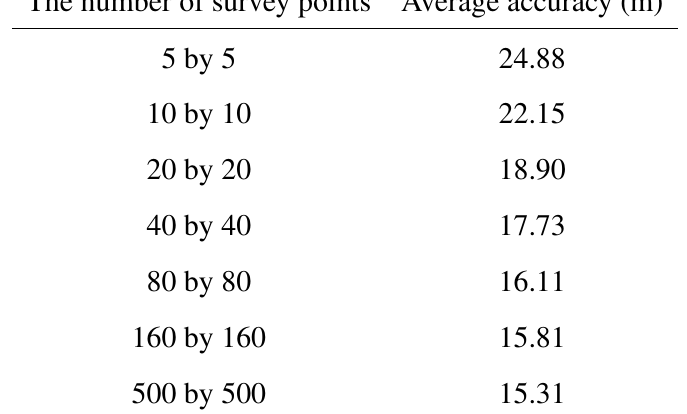
Table 2. The accuracy performance of the kNN approach with various number of sampling points equally spread on a 100 m by 100 m